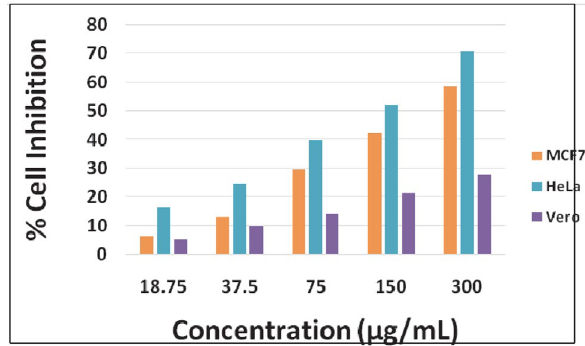
Figure 9. Cytotoxicity of Cu-ZnO NPs in MCF7, HeLa and Vero cell